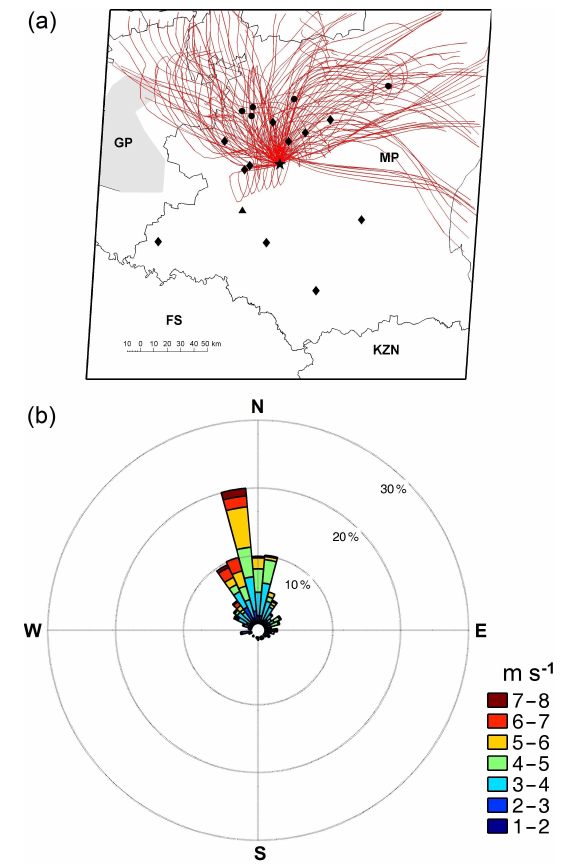
Figure 9. (a) All 24h back trajectories associated with peaks char- acterised by coincidental increases in eBC and H 2 S from December to February. The Elandsfontein site is indicated by the black star. The black dots indicate pyrometallurgical smelters and char plants, the black diamonds coal-fired power plants and the black triangle a large petrochemical operation. (b) Wind rose showing the prevail- ing wind direction during periods when eBC plumes that coincided with H 2 S plumes were